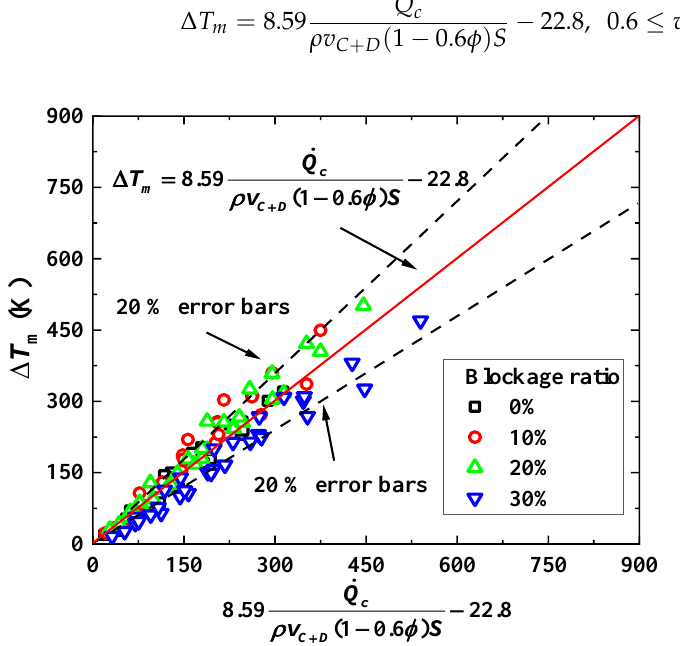
terconnected tunnel blockage rates between 0% and 30%.